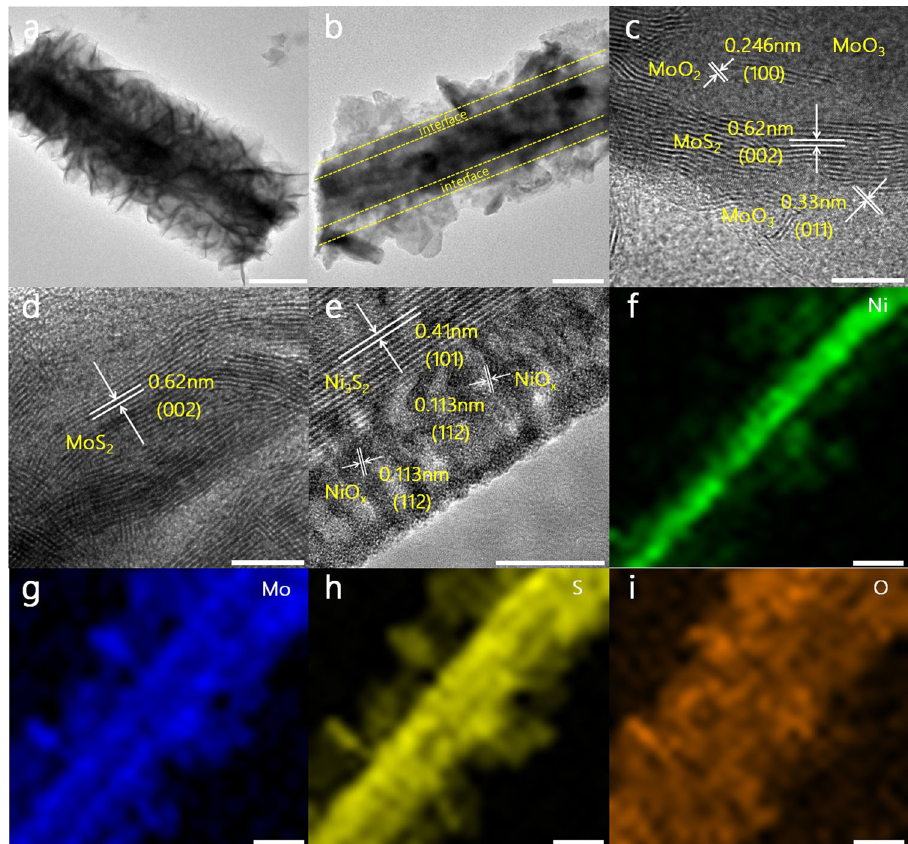
Fig. 3 Morphological and structural characterizations. TEM and HRTEM images of a , d NiMoS and b , c , e NiMoO x /NiMoS. f – i Elemental distribution mapping of Ni, Mo, S, and O in NiMoO x /NiMoS. Scale bar, a , b 500 nm; c – e 5 nm; f – i 200